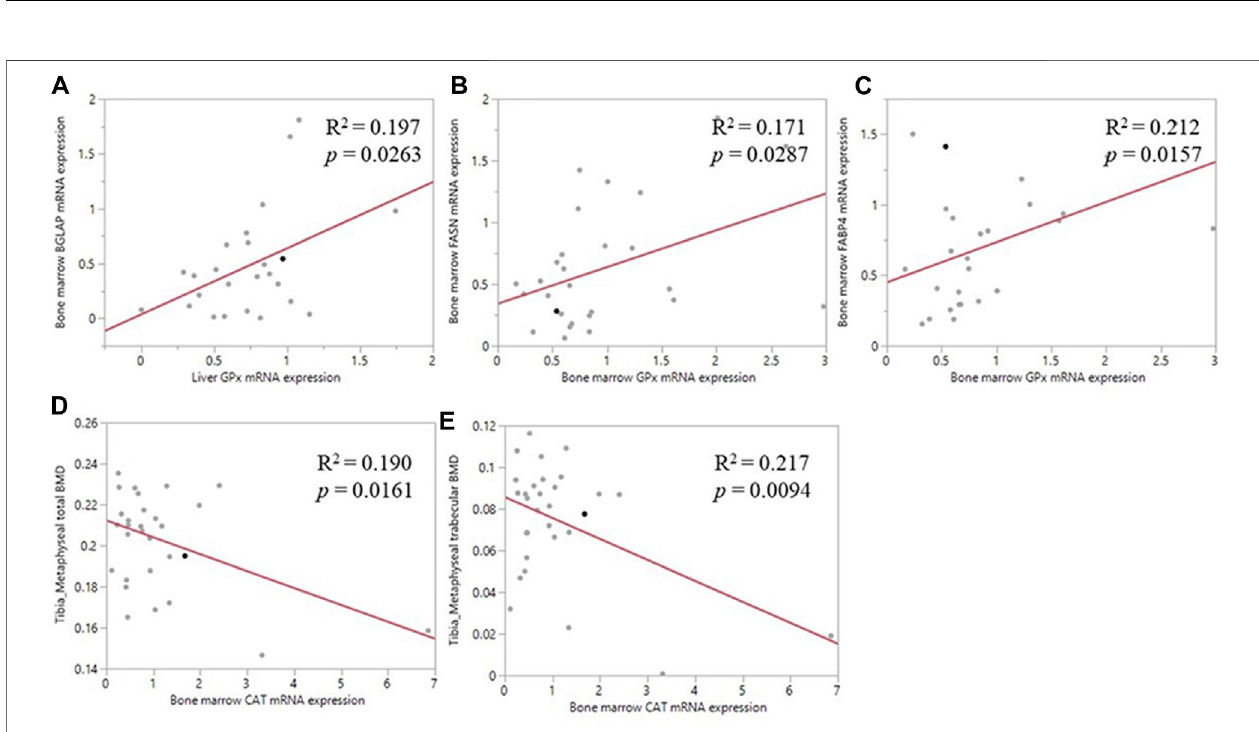
FIGURE5| CorrelationofantioxidantenzymemRNAexpressionandbonerelatedparameters. (A) Thepositivecorrelationbetweenliver GPX1 mRNAlevelandthe bone marrow BGLAP mRNAexpression (B) Thepositivecorrelation betweenbonemarrow GPX1 mRNAexpression and thebone marrow FASN mRNAexpression (C) The positivecorrelationbetween bonemarrow GPX1 mRNA expression and thebetweenbone marrow FABP4 mRNAexpression (D) Thenegativecorrelation between bone marrow CAT mRNA expression and tibia metaphyseal total BMD (E) The negative correlation between bone marrow CAT mRNA expression and tibia metaphyseal trabecular BMD.